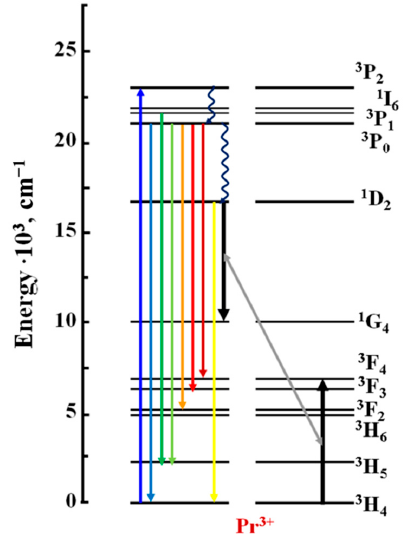
D 2 → 3 H 4 optical transitions of the Pr 3+ ions has been observed before for La 1-x Pr x Ga 0.5 Sb 1.5 O 6 and YPO 4 particles and BaGd 2 (MoO 4 ) 4 crystals doped with Pr 3+ ions [40–42].